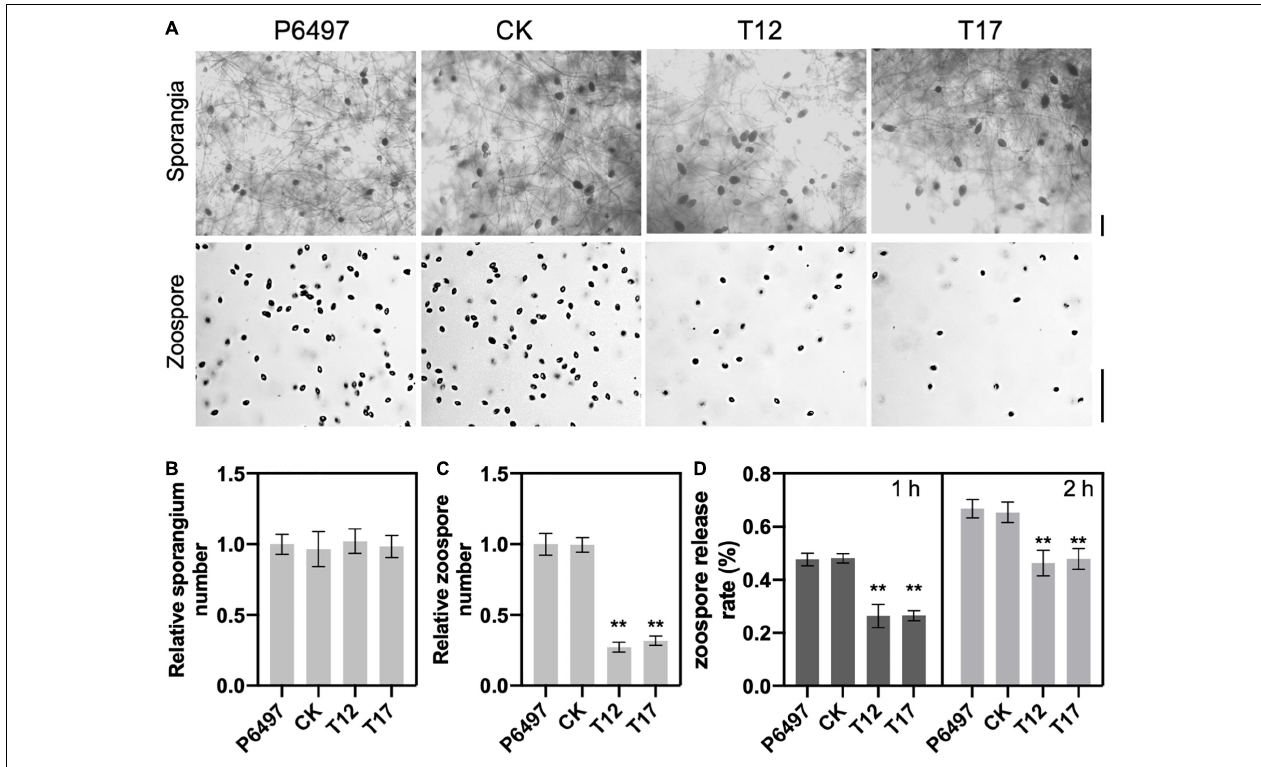
FIGURE 3 | PsGRASP is required for zoospore release. (A) Microscopic visualization of sporangia and zoospores. Scale bar, 50 µ m. (B,C) Quantification of zoospore and sporangia production. All experiments were repeated three times with similar results obtained. (D) Reduced numbers of zoospore production were observed in both PsGRASP -knockout mutants (T12 and T17). Zoospores released by the indicated lines were counted after 1 and 2 h of sporangial induction. The data shown represent three independent experiments. Error bars denote SD. ** P < 0.01, Student’s t